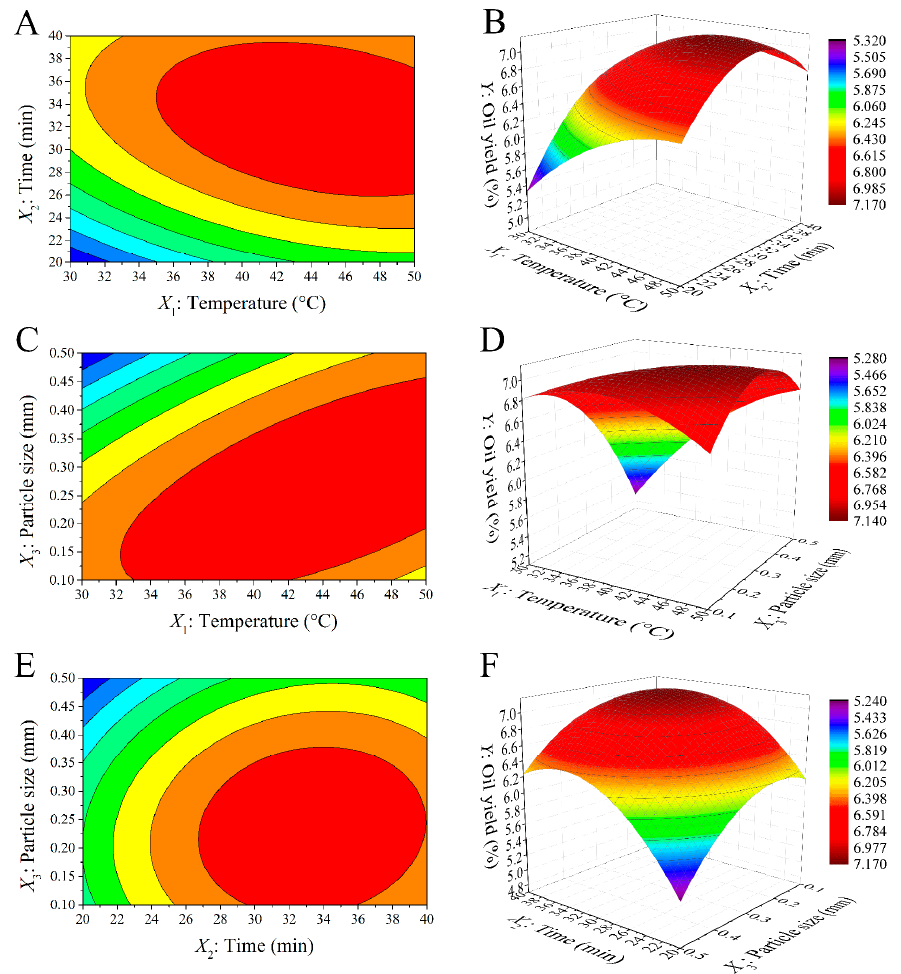
Figure 2. Contour plots ( A , C , E ) and response surface plots ( B , D , F ) of the oil yield affected by extraction temperature (°C, X 1 ), time (min, X 2 ) and raw material particle size (mm, X 3 ).